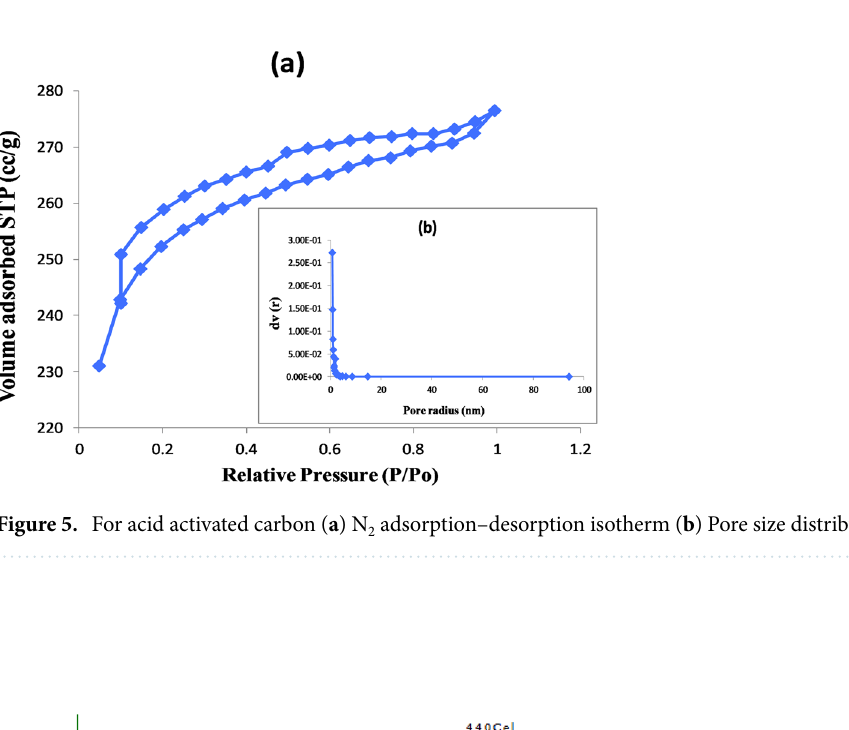
Table 3. Comparison analysis of Surface area, pore volume of different activated carbons.